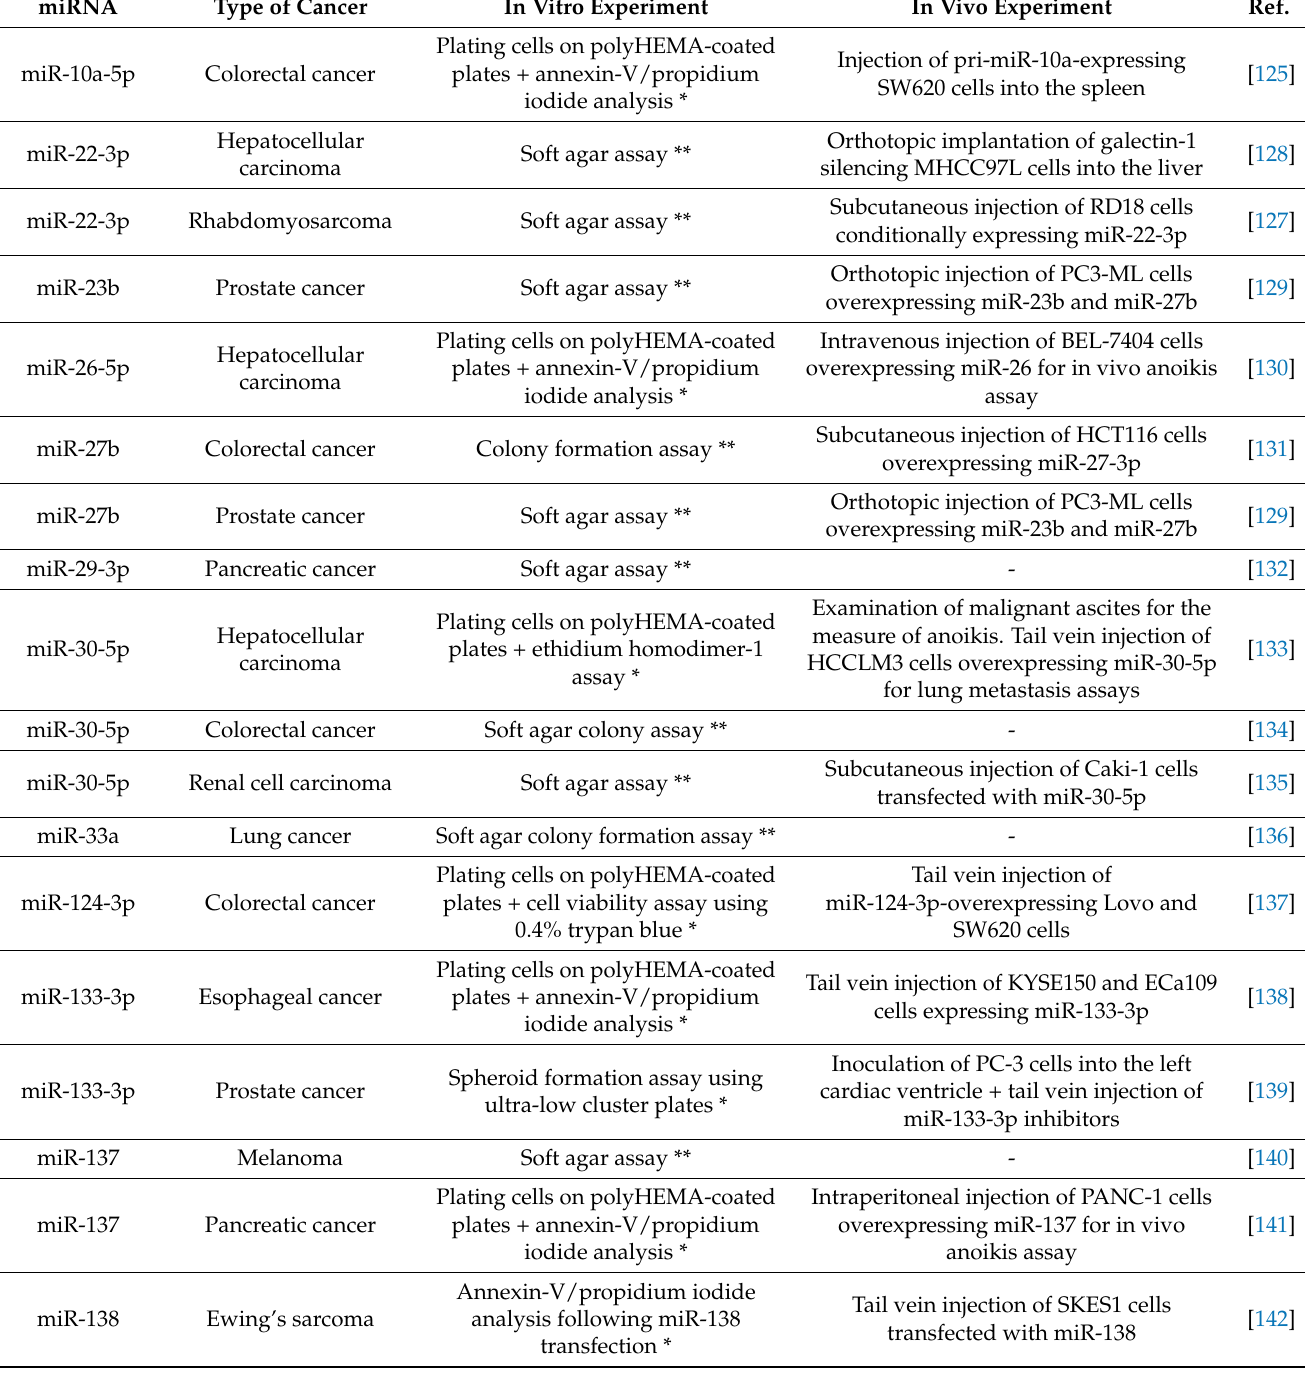
Table 2. Tumor-suppressive miRNAs that suppress the anoikis resistance and anchorage-independent growth of cancer. miRNA Type of